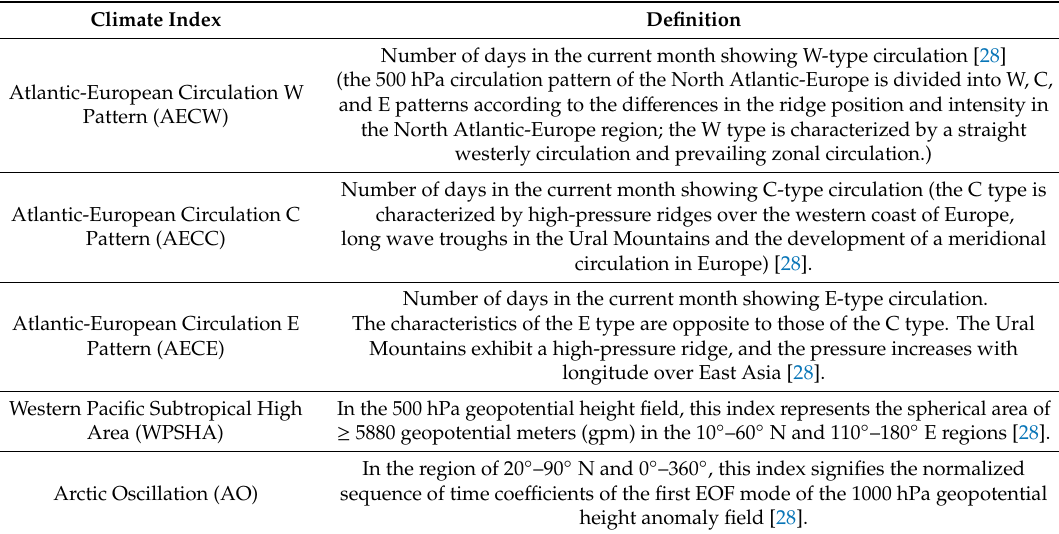
Table 1. Definition of atmospheric circulation